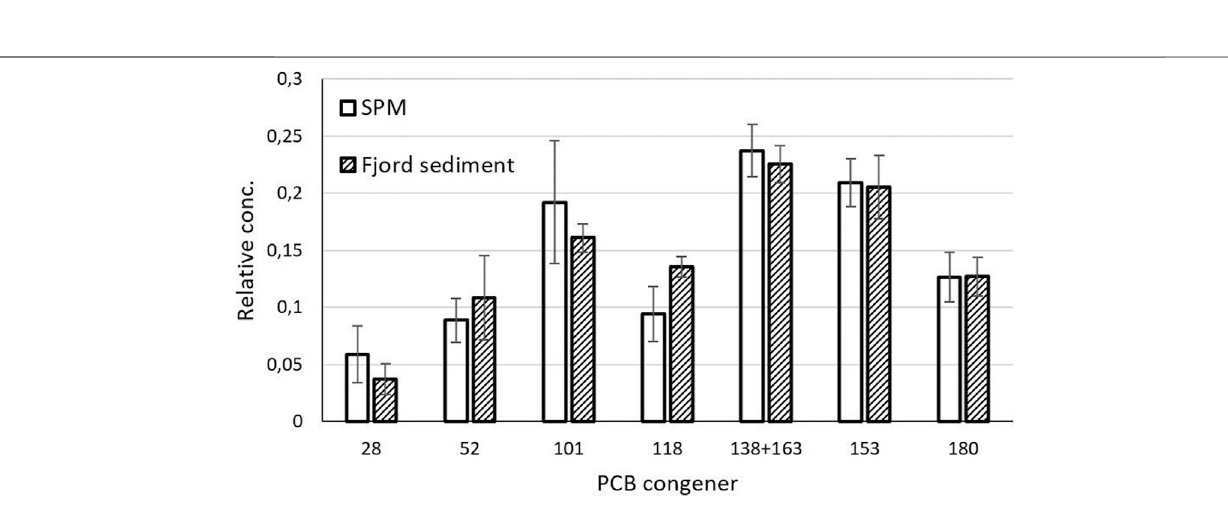
Frontiers in Environmental Science |